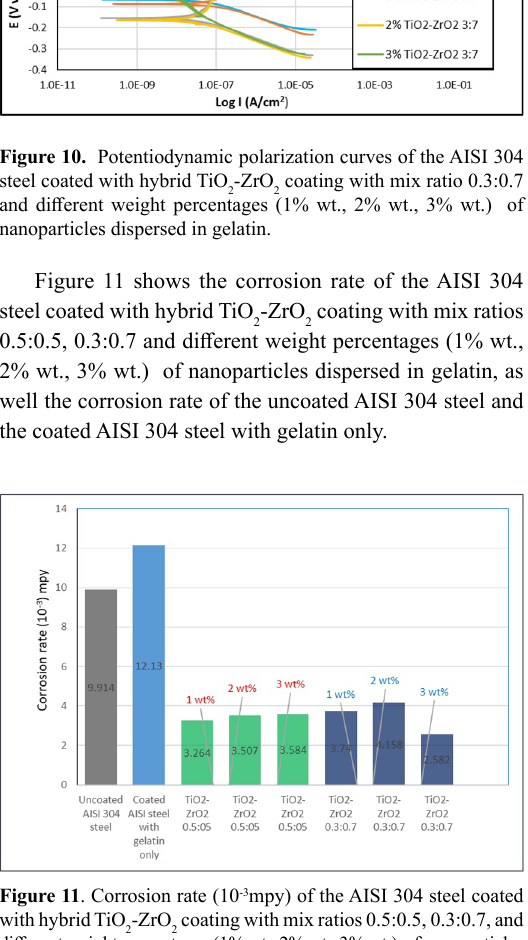
-ZrO coating with mix ratio 2 2